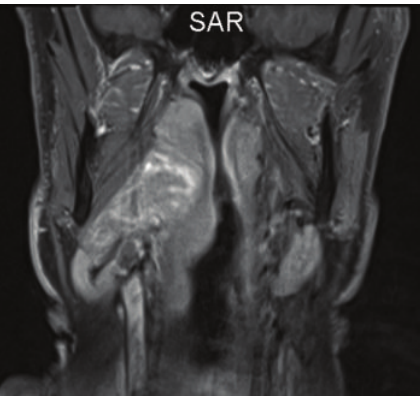
Figure 1: MRI ARM parapharyngeal space with submandibular